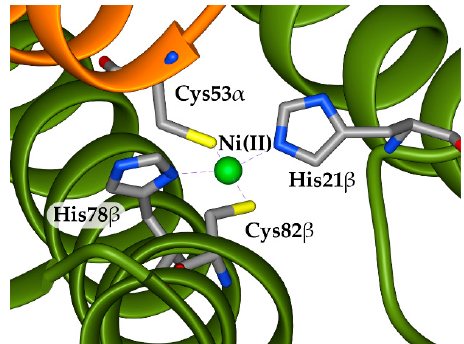
Figure 5. Results for the H21(N ε )–H78(N δ ) modelling of Ni(II) bound Sy InrS starting from the protein in the holo conformation. The Sy InrS backbone is reported as ribbons coloured by polypeptide chains, with chain α in orange and chain β in green. Putative metal binding residues are reported as sticks coloured according to atom types. The Ni(II) ion is shown as a green